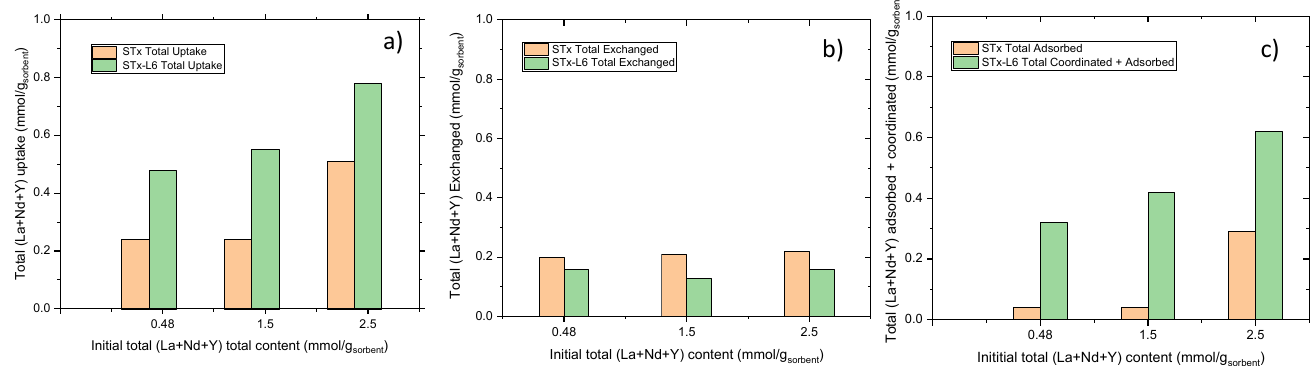
Figure 7. Uptake in trionic solution: ( a ) total, ( b ) exchanged, and ( c ) adsorbed/coordinated at increasing initial ion contents for pristine STx and modified STx-L6.